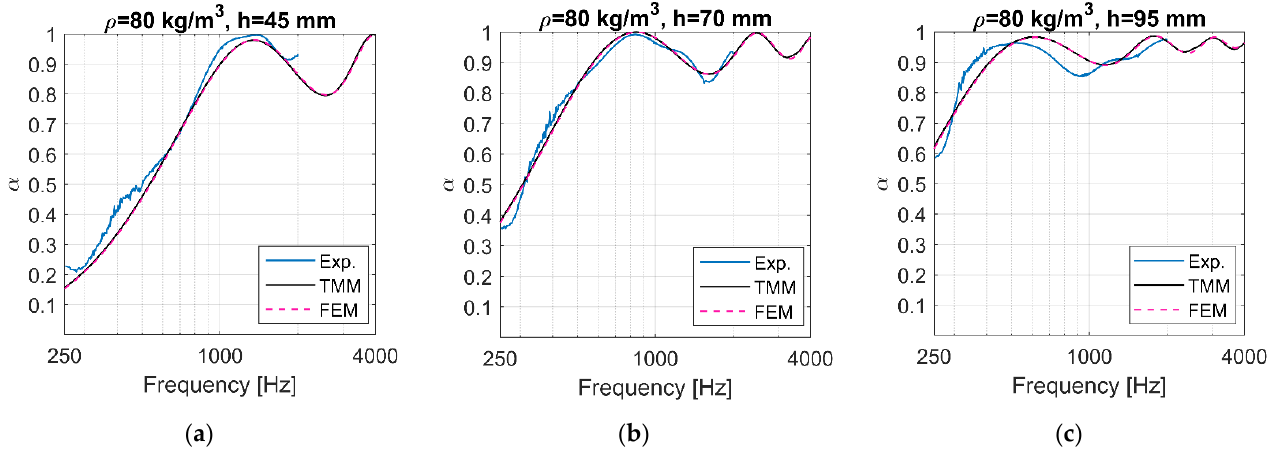
Figure 9. Comparisons between experimental results, TMM and FEM for RPU foams with ρ = 80 kg/m 3 .